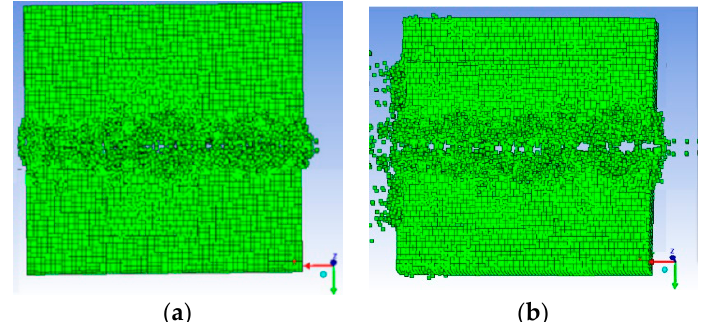
Figure 14. Simulation e ff ect after explosion. ( a ) Laminates tend to separate exactly, ( b ) Laminate is broken.